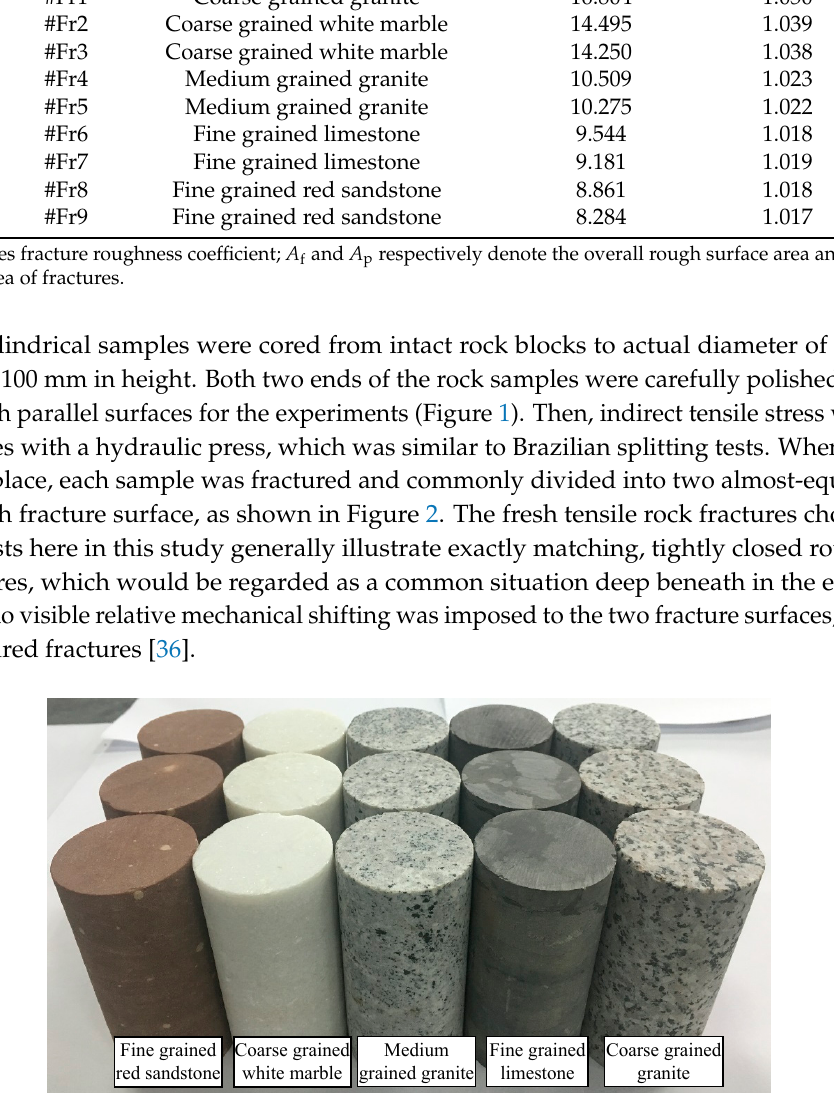
Figure 2. Preparation of rough-walled rock fractures using tensile splitting of an intact cylindrical sample. 3.2. Quantification of Fracture Surface Roughness In order to reveal the effects of fracture surface morphology on hydromechanical characteristics of rock fractures prior the flow-through experiments, accurate quantification of roughness for each rock fracture must be measured. A high-resolution noncontact 3D Laser Scanning (JR noncontact 3D Laser Scanning, Beijing Jirui Xintian Technology CO., LTD, Beijing, China), was adopted to achieve the rough rock fracture surface data, which were automatically recorded in a 0.1 mm internal in the fracture surface plane, and have a vertical ( z -direction) precision of ±1 μ m [8]. The 3D views of digitized surfaces of the tested fractures are displayed in Figure 3.